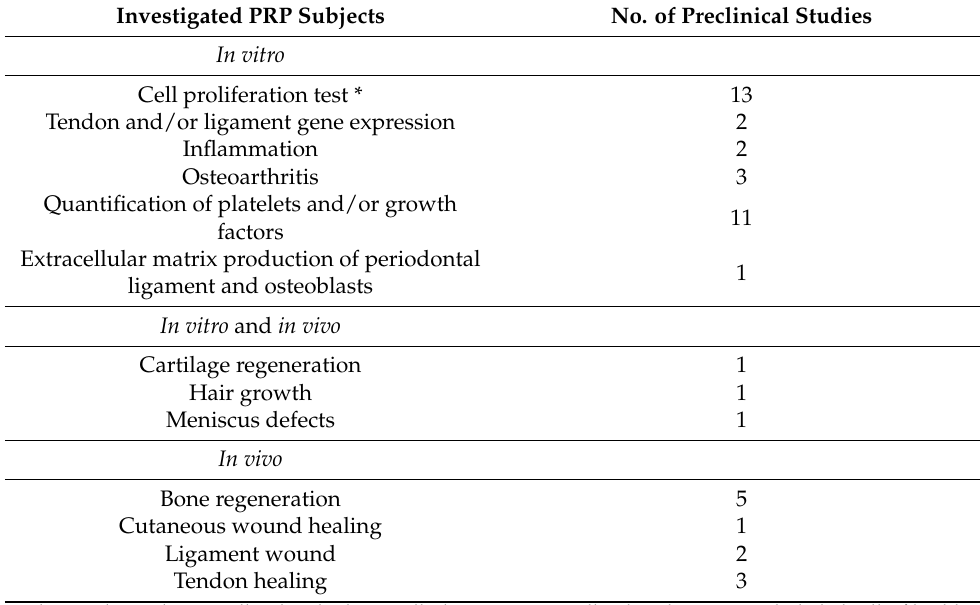
Table 4. Subjects investigated among top-cited preclinical